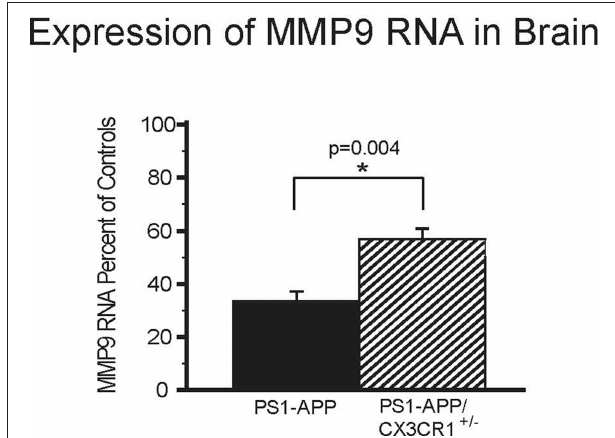
FIGURE 5 | Effects of CX3CR1-deficiency on levels of MMP9 RNA in the whole brains of PS1-APP mice. RNA was extracted from brains of PS1-APP, WT, PS1-APP-CX3CR1 + / − , and CX3CR1 + / − mice and assessed for expression of MMP9 by qPCR. Data are expressed as mean percent of appropriate control ± SEM ( n = 6 per genotype). * represent statistically